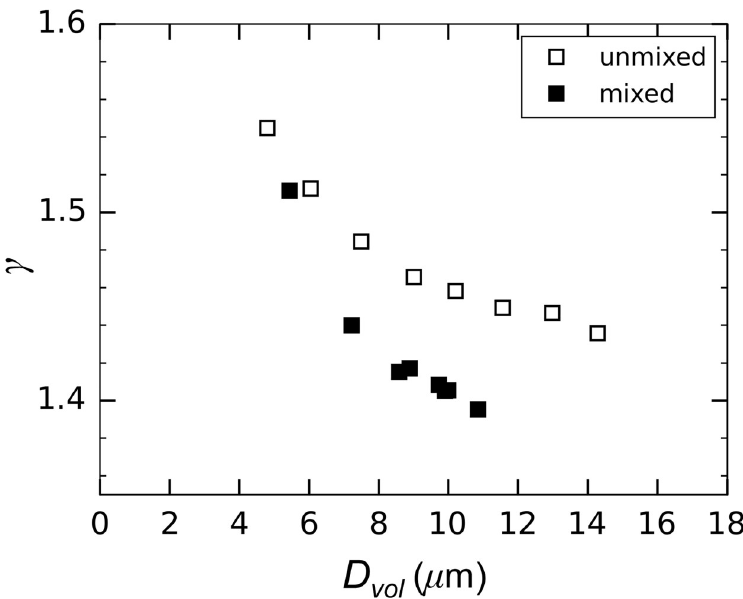
Fig 12. Response of the spectral slope of attenuation with changes in the particle volume-weighted mean diameter after flowing through the siphon tubes.